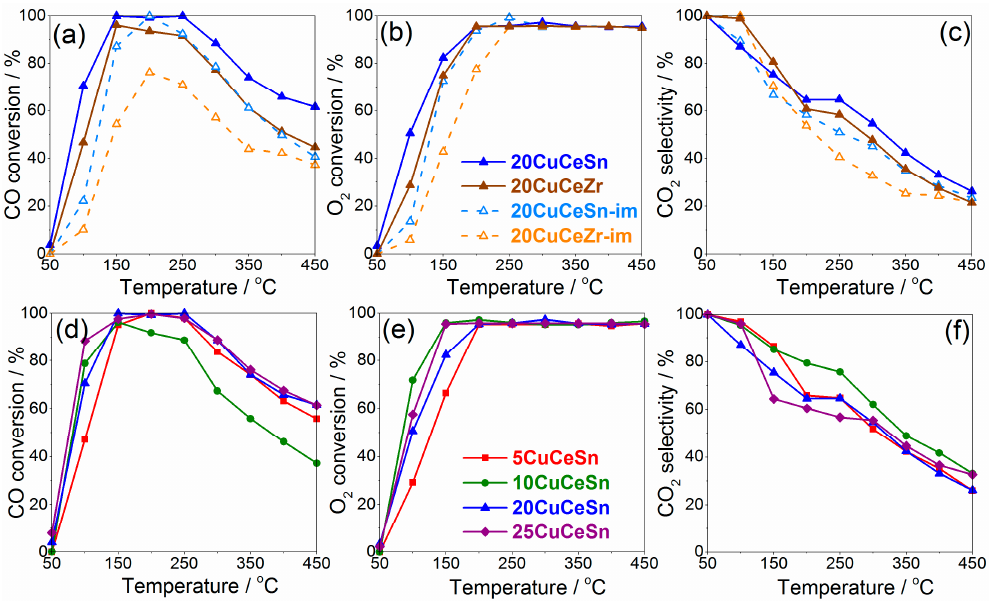
Figure 1. CO ( a , d ) and O 2 ( b , e ) conversions and CO 2 selectivity ( c , f ) vs. reaction temperature for CuCeSn and CuCeZr catalysts with the same ( a – c ) and different ( d – f ) copper contents.